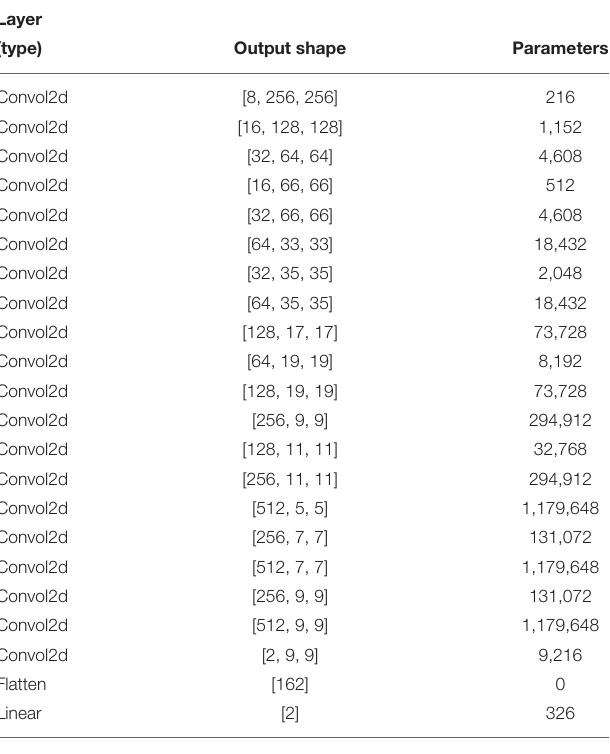
TABLE 4 | The number of layers and layer parameters of the proposed DarkASDNet model. Layer